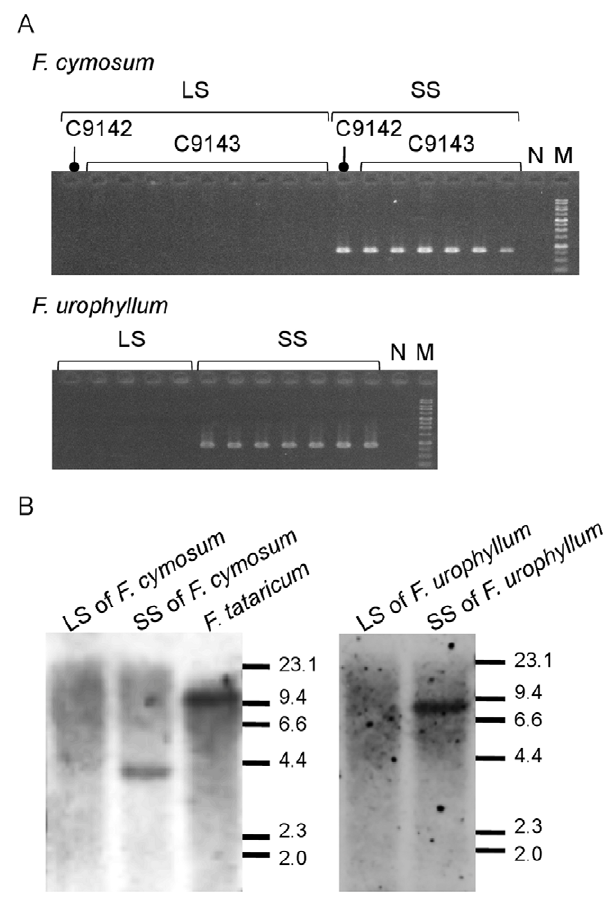
Figure 6. Analysis of S-ELF3 in Fagopyurm species. (A) PCR survey of S-ELF3 in heteromorphic and self-incompatible species, F. cymosum and F. urophyllum . LS, plant with long-styled flowers. SS, plant with short-styled flowers. N, negative control. M, molecular marker (1-kb DNA Ladder, GeneDireX) (B) Southern blot analysis of S-ELF3 in F. cymosum , F. tataricum , and F. urophyllum . Fragment sizes of the l Hin dIII marker shown at the right are in kb. See Table S2 for accession numbers (C9142 and C9143).